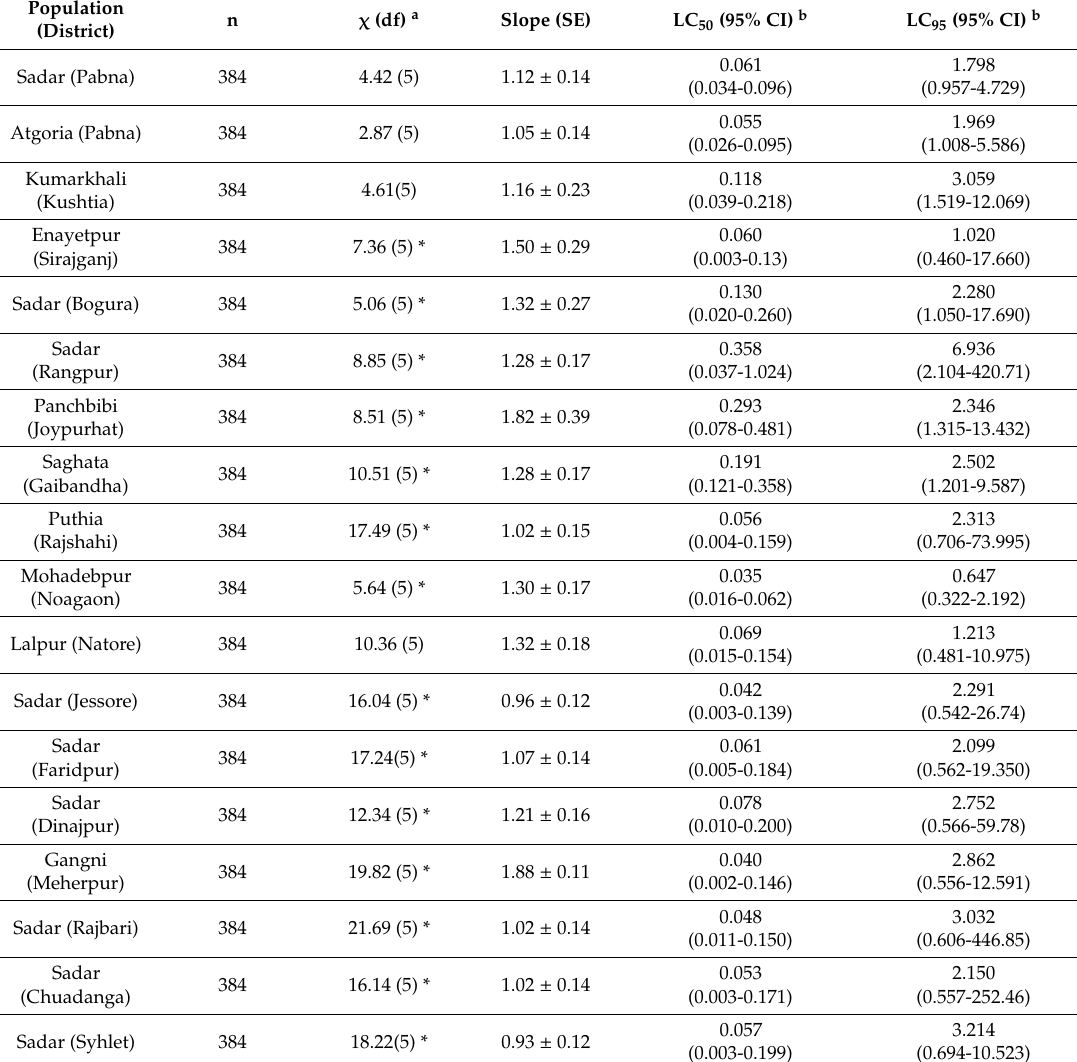
Table 2. Probit analysis of mortality (LC values) of Leucinodes orbonalis neonates to diet-incorporated Cry1Ac protein (ppm). Populations were collected in Bangladesh in